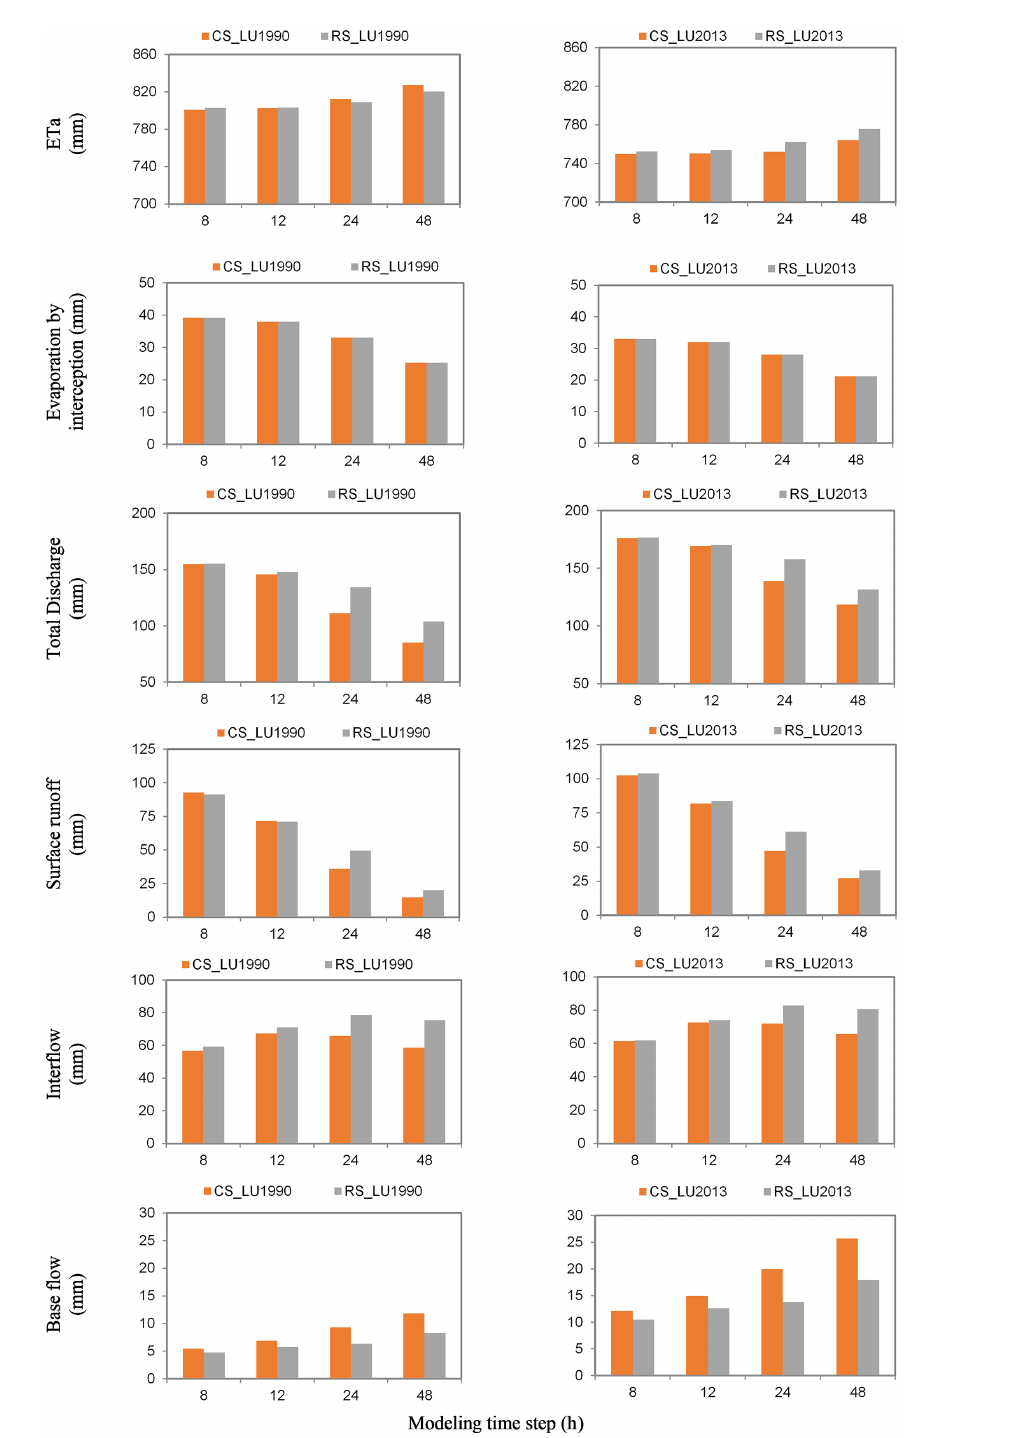
Figure 4. Annual water balance components for different modeling time steps and soil parameterization approaches for the period of January 2013 to December